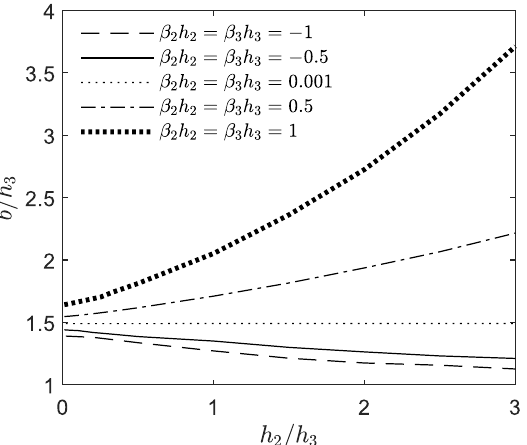
Figure 9. The dependence of non–dimensionalized receding contact half–length on the thickness ratio h 2 / h 3 for different inhomogeneity parameters β 2 h 2 and β 3 h 3 ( µ 03 = µ 1 , a / h 3 = 0.5 )